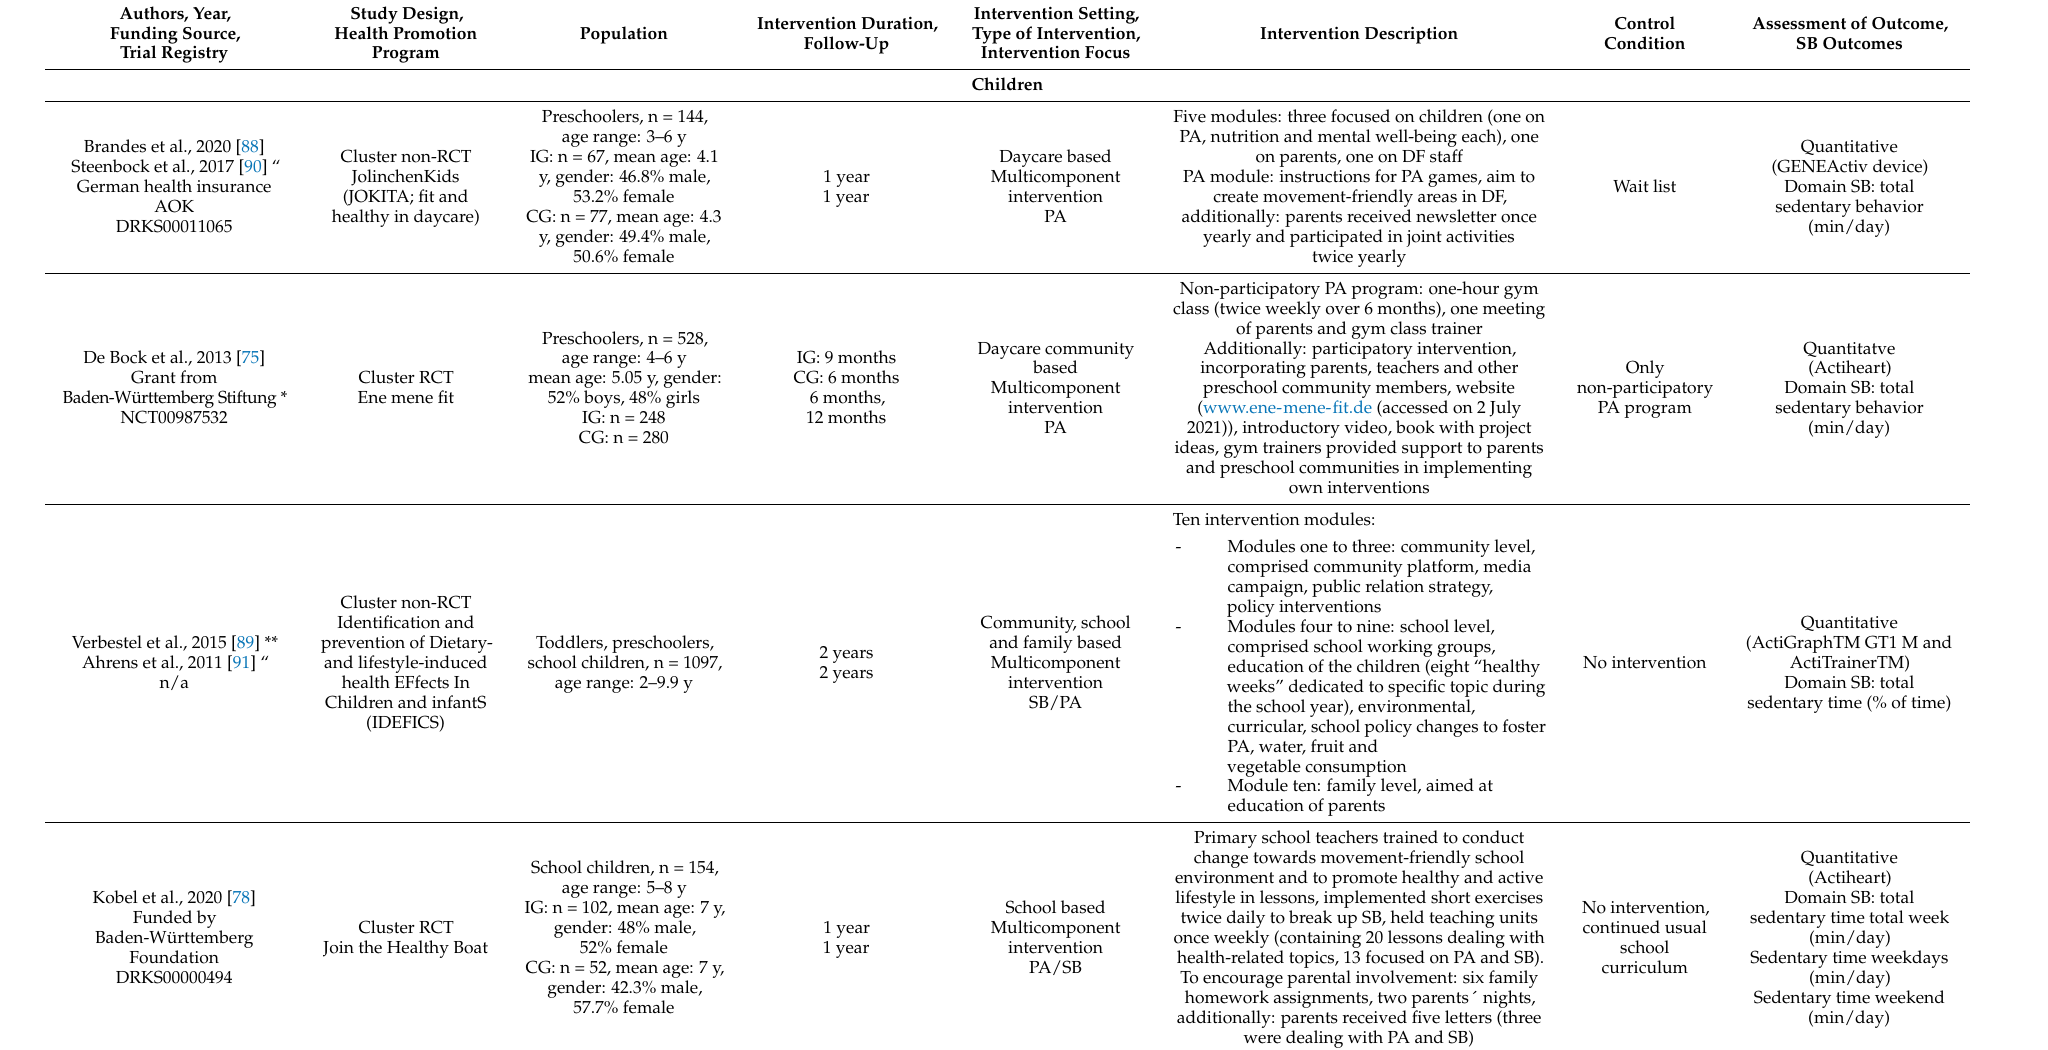
Table 1. Characteristics of included